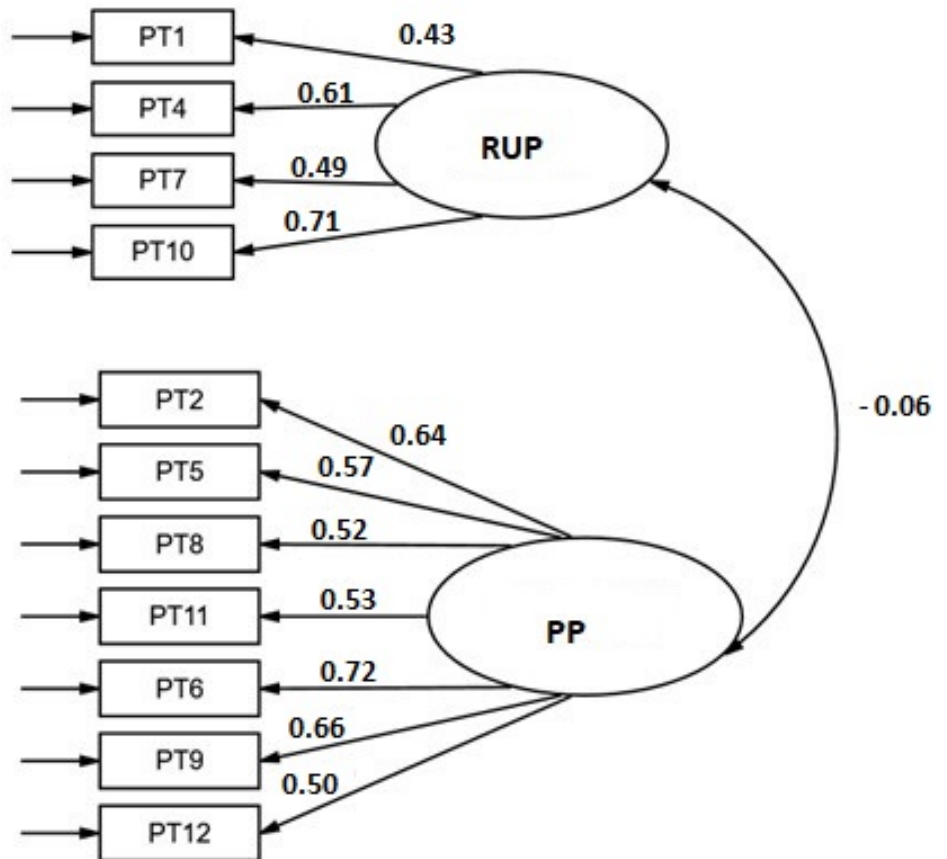
Figure 2. Structural model for the Persistence scale. Standardized weights.